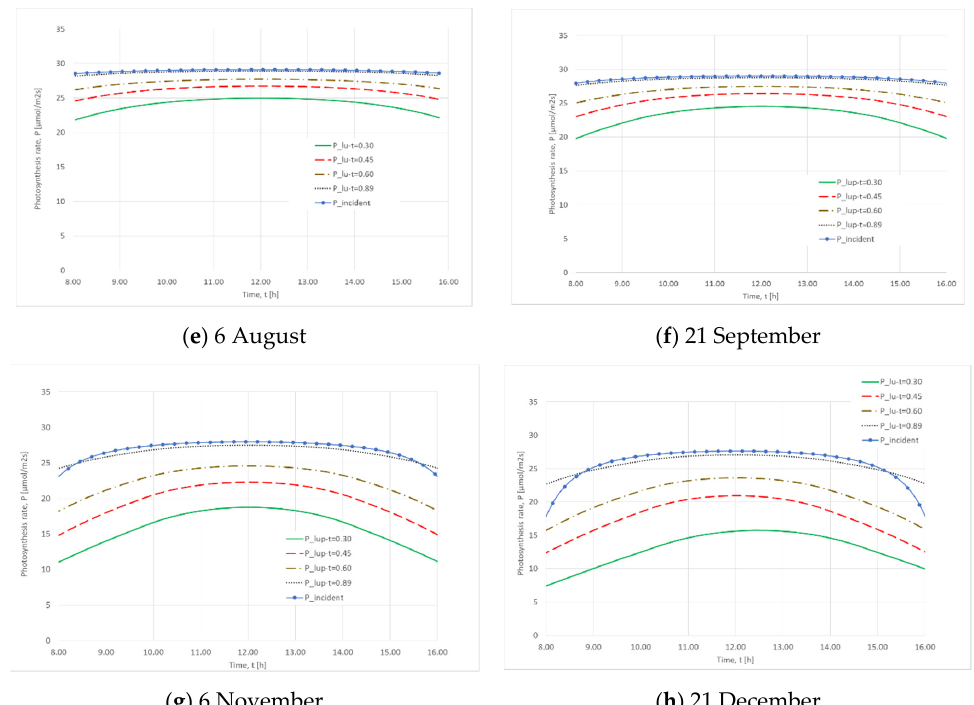
Figure 8. Photosynthesis rate at plant level during the solar day for 8 indicative days of the year. (i) τ n,PAR = 30% (green line continuous), (ii) τ n,PAR = 45% (red dashed line), (iii) τ n,PAR = 60% (brown dot-dashed line), (iv) τ n,PAR = 89%—bare cover (black dotted line), and (v) photosynthesis rate in open field (blue continuous line with blue circles).